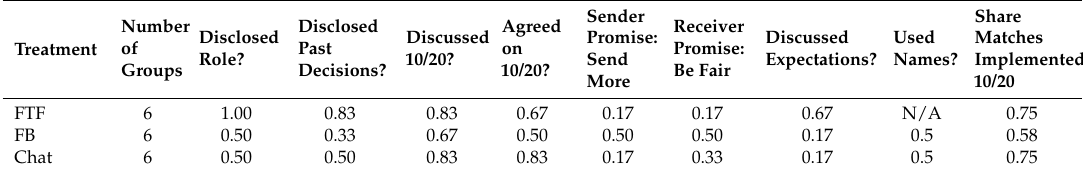
Table 7. Summary of group